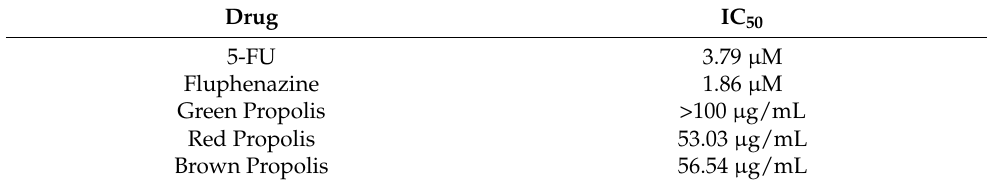
Table 4. Individual IC 50 of 5-FU, fluphenazine and propolis in HT-29 colon cancer cells.